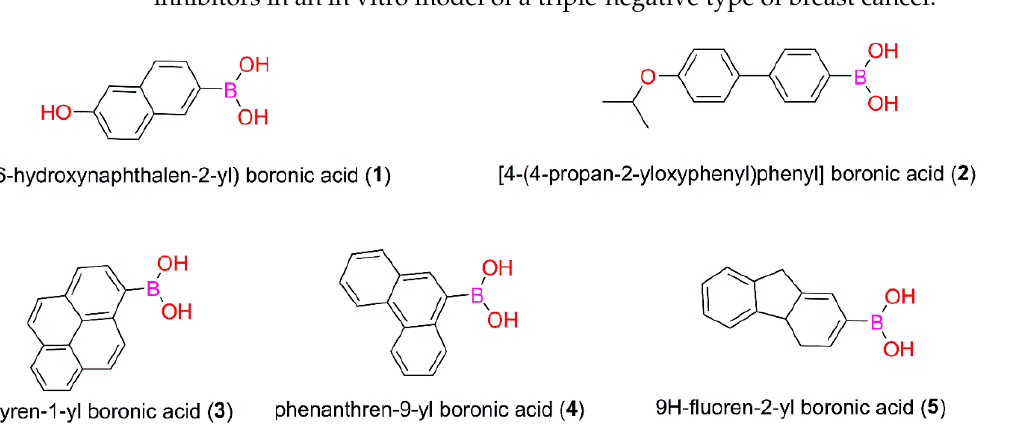
Figure 1. Chemical structures and IUPAC names of selected boronic acid derivatives. See the methods section regarding the selection procedure.